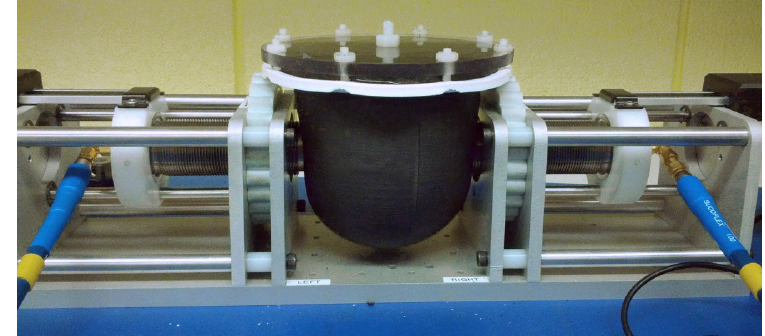
Figure 8. Transmission system with the breast phantom